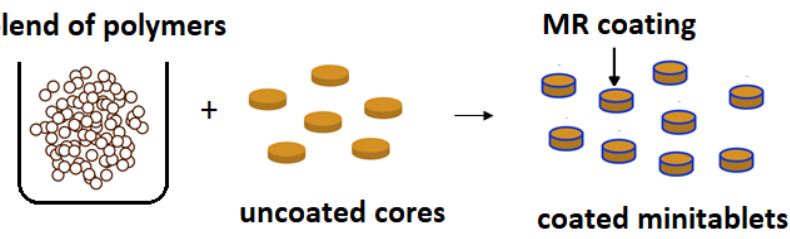
Figure 3. Schematic illustration of coated modified release (MR) minitablets.